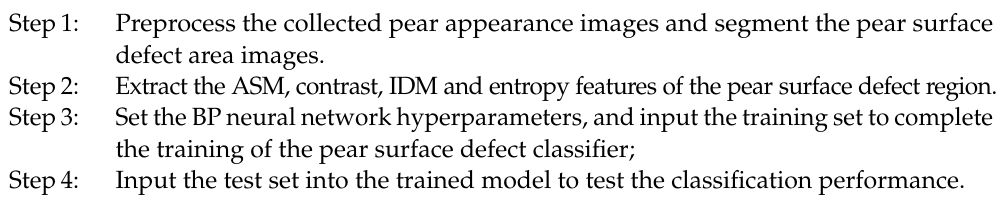
Figure 8. Pear surface defect BP neural network classifier.